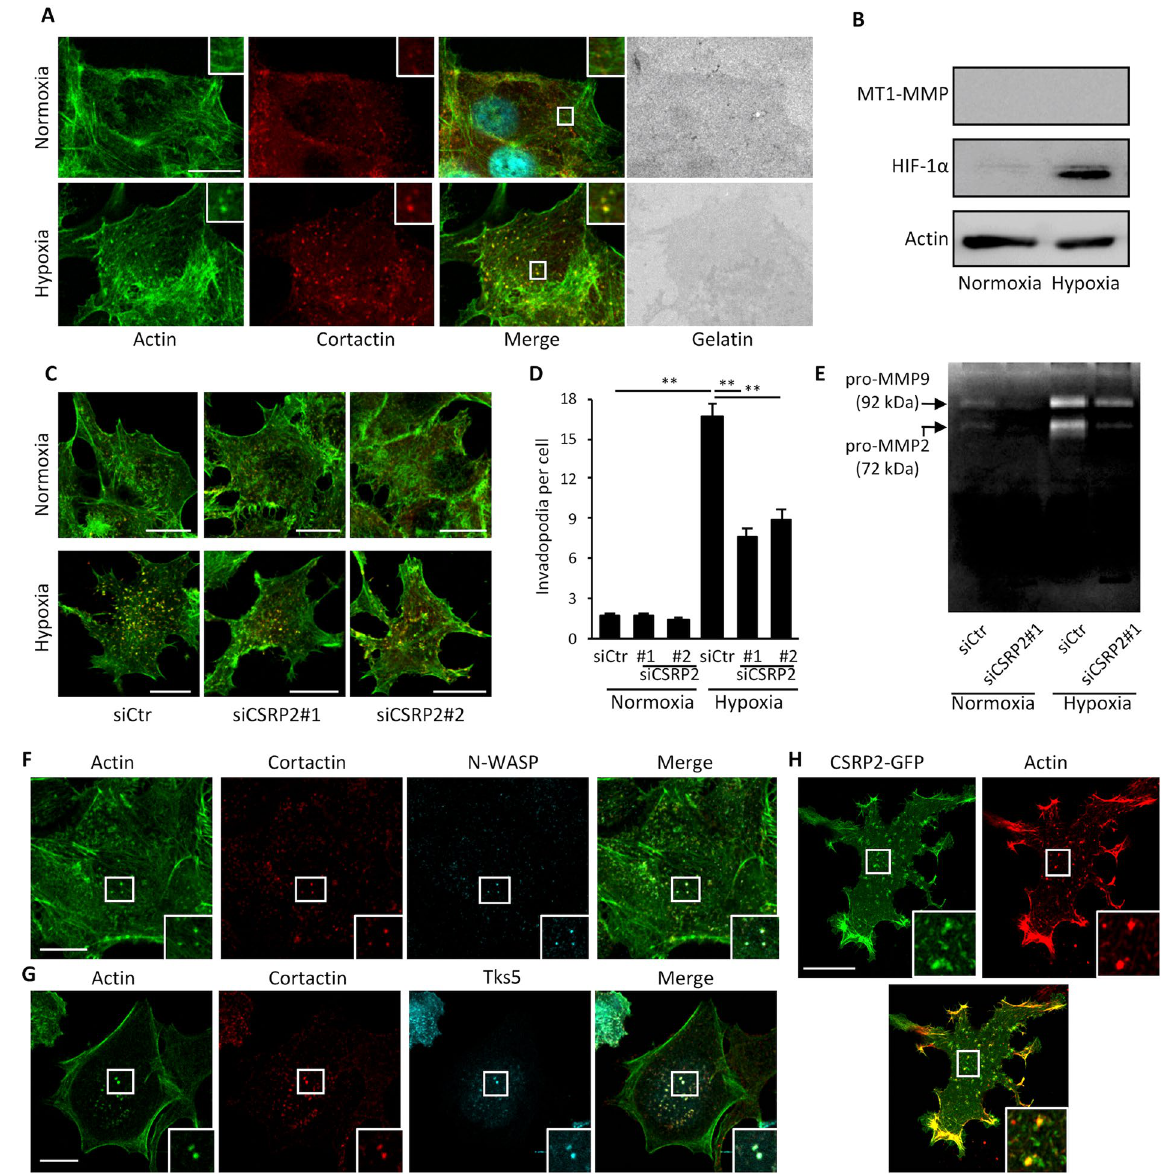
Figure 4. Hypoxia-induced invadopodium precursors formation in MCF-7 cells requires CSRP2 upregulation. ( A ) Gelatin degradation assay showing that normoxic (upper panels) and hypoxic (lower panels) MCF-7 cells do not promote (Oregon Green 488-labelled) gelatin degradation after 48 h. After fixation, MCF-7 cells were stained for actin (in green) and cortactin (in red), and imaged using confocal microscopy. ( B ) Western blot analysis of the MT1-MMP and HIF-1 α protein levels in normoxic and hypoxic MCF-7 cells. ( C ) MCF-7 cells were transfected with non-targeting or 2 different CSRP2 siRNAs (siCSRP2#1 and 2), cultured under normoxic or hypoxic conditions, and invadopodium precursors were detected by actin (green) and cortactin (red) co-labelling. ( D ) Quantitative analysis of invadopodium precursor density in MCF-7 cells as in ( C ). The data originate from 3 independent experiments (n = 60). ( E ) Gelatin zymography assay conducted with the conditioned media collected from MCF-7 cells cultured as in ( C , D ). The zymogram is representative of three independent experiments. Similar data were obtained with siCSRP2#2. ( F , G ) Hypoxic MCF-7 cells were labelled for actin (green), cortactin (red) and either N-WASP (immunolabelling, F ) or Tks5 (Tks5-GFP, G ). ( H ) CSRP2-GFP co-localizes with actin (red) at invadopodium precursors in hypoxic MCF-7 cells. The insets show magnification of invadopodium precursors. Bars = 15 µ m; * p < 0.05; ** p <